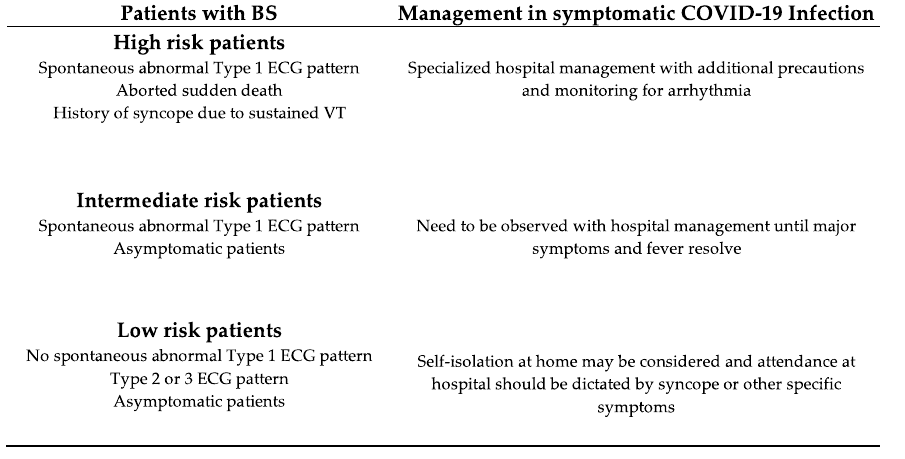
Figure 6. BS and symptomatic COVID-19 infection. Risk stratification and flow charts for hospital or home care management, based on Dendramis et al., 2020 [8].